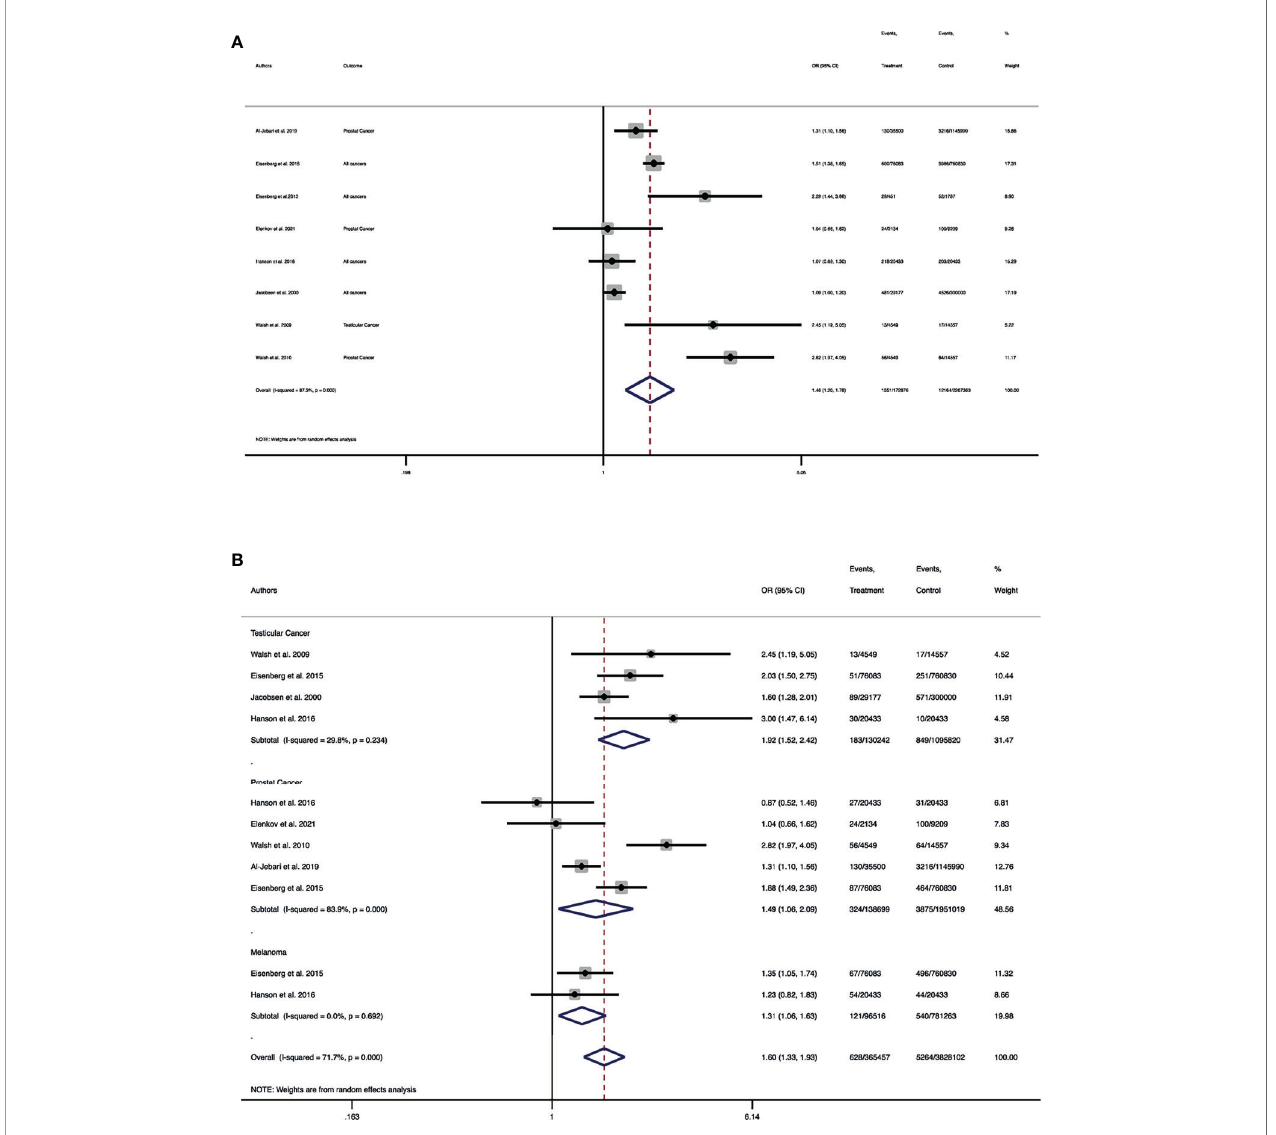
FIGURE 2 | Forest plot of pooled odds ratio for (A) composite outcome of all cancers; (B) individual cancers of testicular, prostate and melanoma. (A) Forest plot of the pooled odds ratio for the composite outcome of all cancers. (B) Forest plot of pooled odds ratio for testicular cancer, prostate cancer and